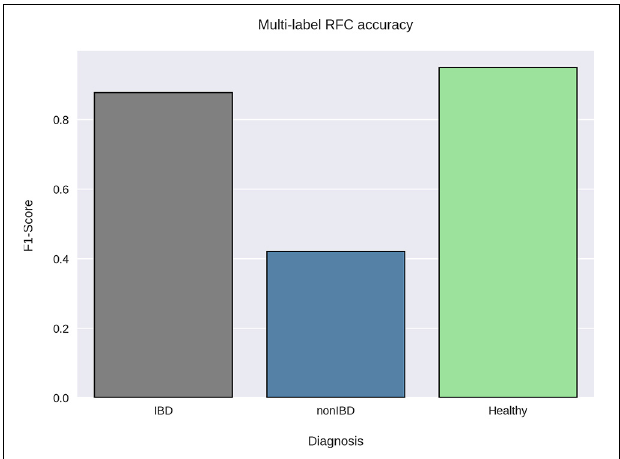
FIGURE 3 | RFC classification accuracy by sample group. A random forest classifier was trained on taxonomic profiles and sample metadata using the diagnoses as the sample labels. The Healthy-1 and Healthy-2 cohorts were grouped together under one label (Healthy) as our goal was to classify samples by diagnosis. The F1-score was then calculated for each label using the precision and recall of the best-performing RFC model via threefold cross-validation. The RFC was able to accurately classify healthy and IBD samples using their taxonomic profiles but was not able to accurately classify non-IBD